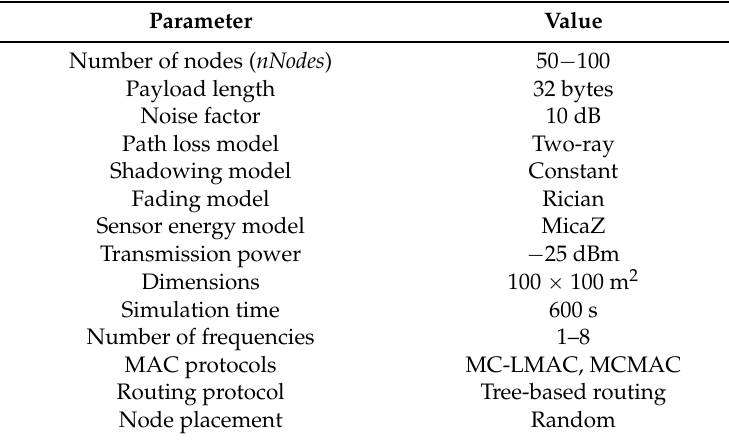
Table 1. Some key simulation parameters and